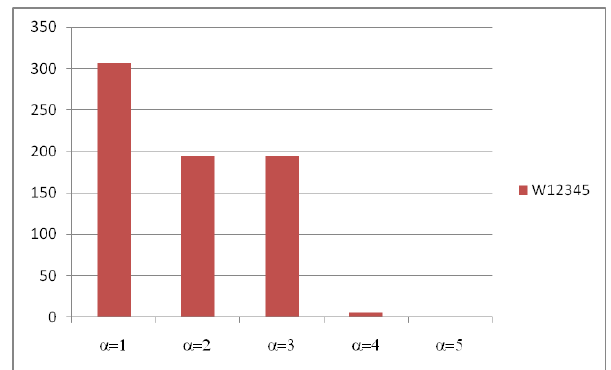
Figure 7 Number of users who are active during the whole analysed time period (W12345) depending on α value